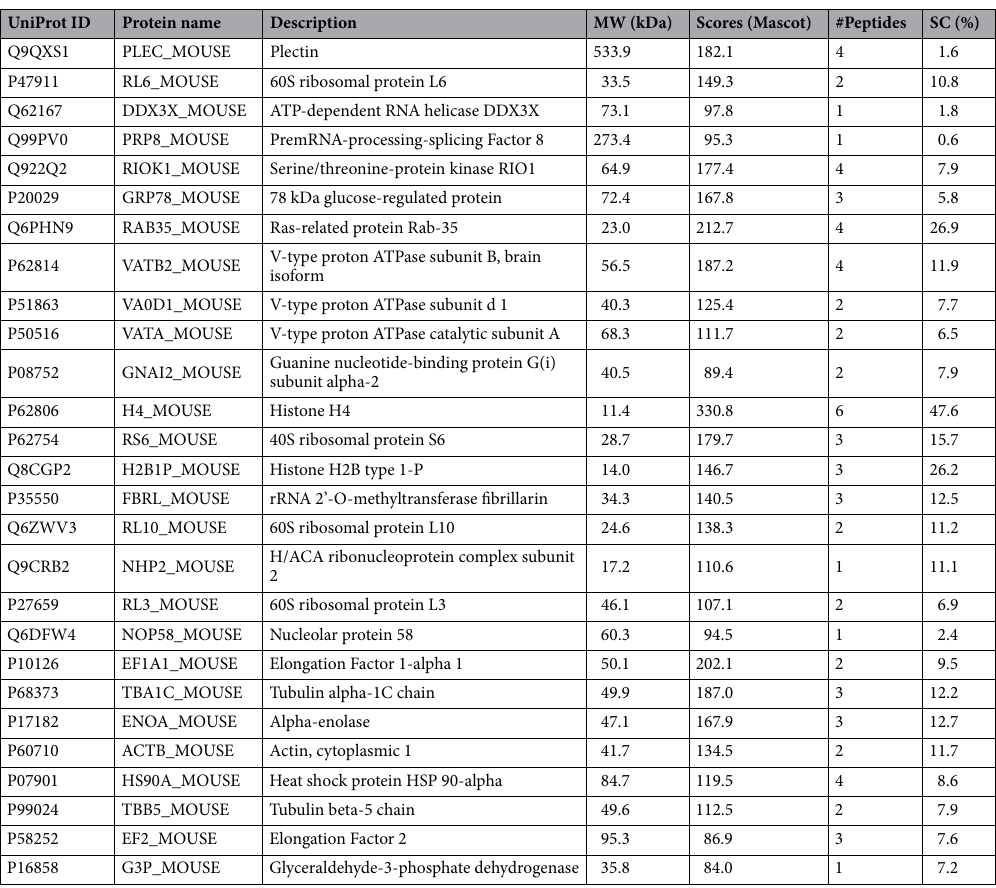
Table 1. List of TBC1D10C-interacting proteins in samples from RAW 264.7 macrophages. Conserved proteins identified between the GFP-tagged control vector and GFP-tagged TBC1D10C were discarded (results from 4 independent experiments). SC: Sequence coverage. TBC1D10C was identified but not included in the